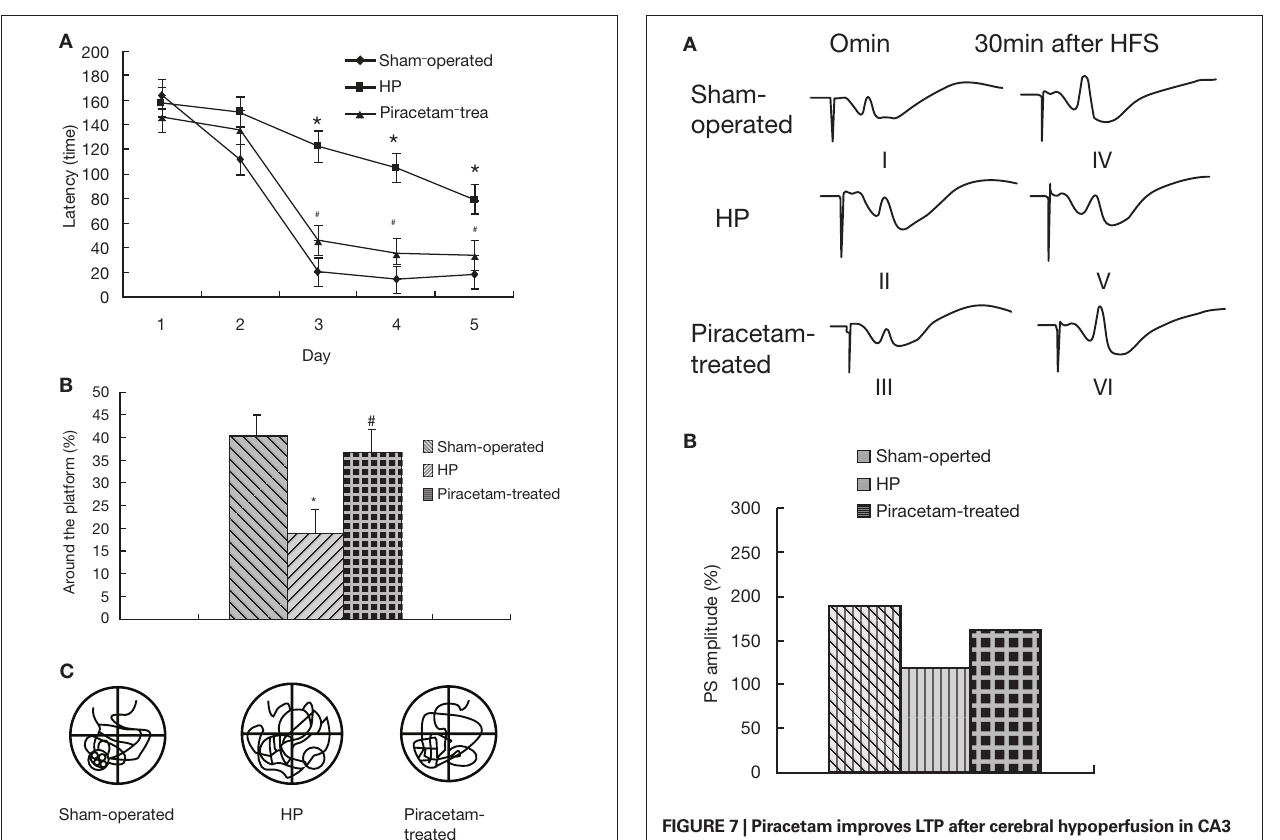
Figure 7 | Piracetam improves LTP after cerebral hypoperfusion in CA3 synapses. Changes in LTP after ligature of carotoids induced as described by He et al. (2008). The animals were treated in the Sham-operated group (I, IV) and in the HP group (II, V) for 30 days with saline, and in the piracetam group (III, VI) with 600 mg/kg per day. (A) LTP was blocked in the HP group and improved in the piracetam treated group. (B) Improvement of the population spike (PS) by piracetam ( n = 7–8 ± SEM). Data are reproduced from He et al. (2008) with permission. * p < 0,01 vs. Sham-operated, and # p < 0.05 vs. control hypoperfusion. One-way ANOVA followed by Fisher LSD